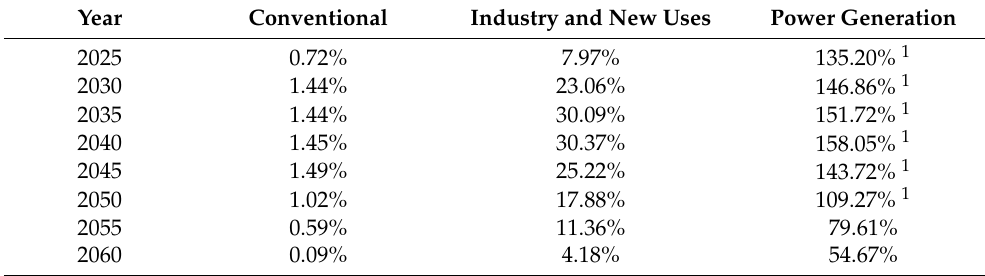
Table 2. P NG,sector,year values.